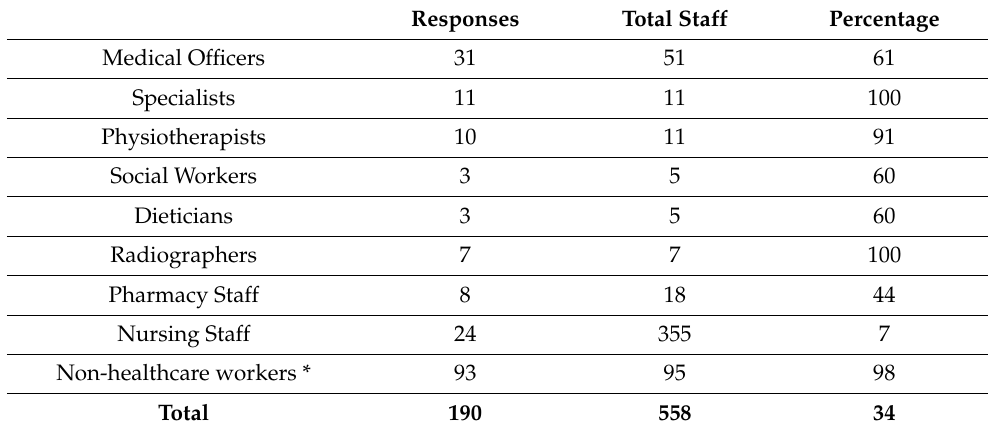
Table 1. Survey responses by staffing categories.